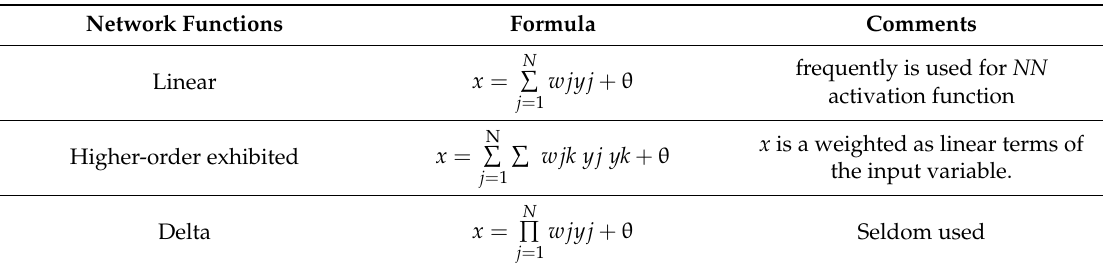
Table A2. Summary of neural network functions.